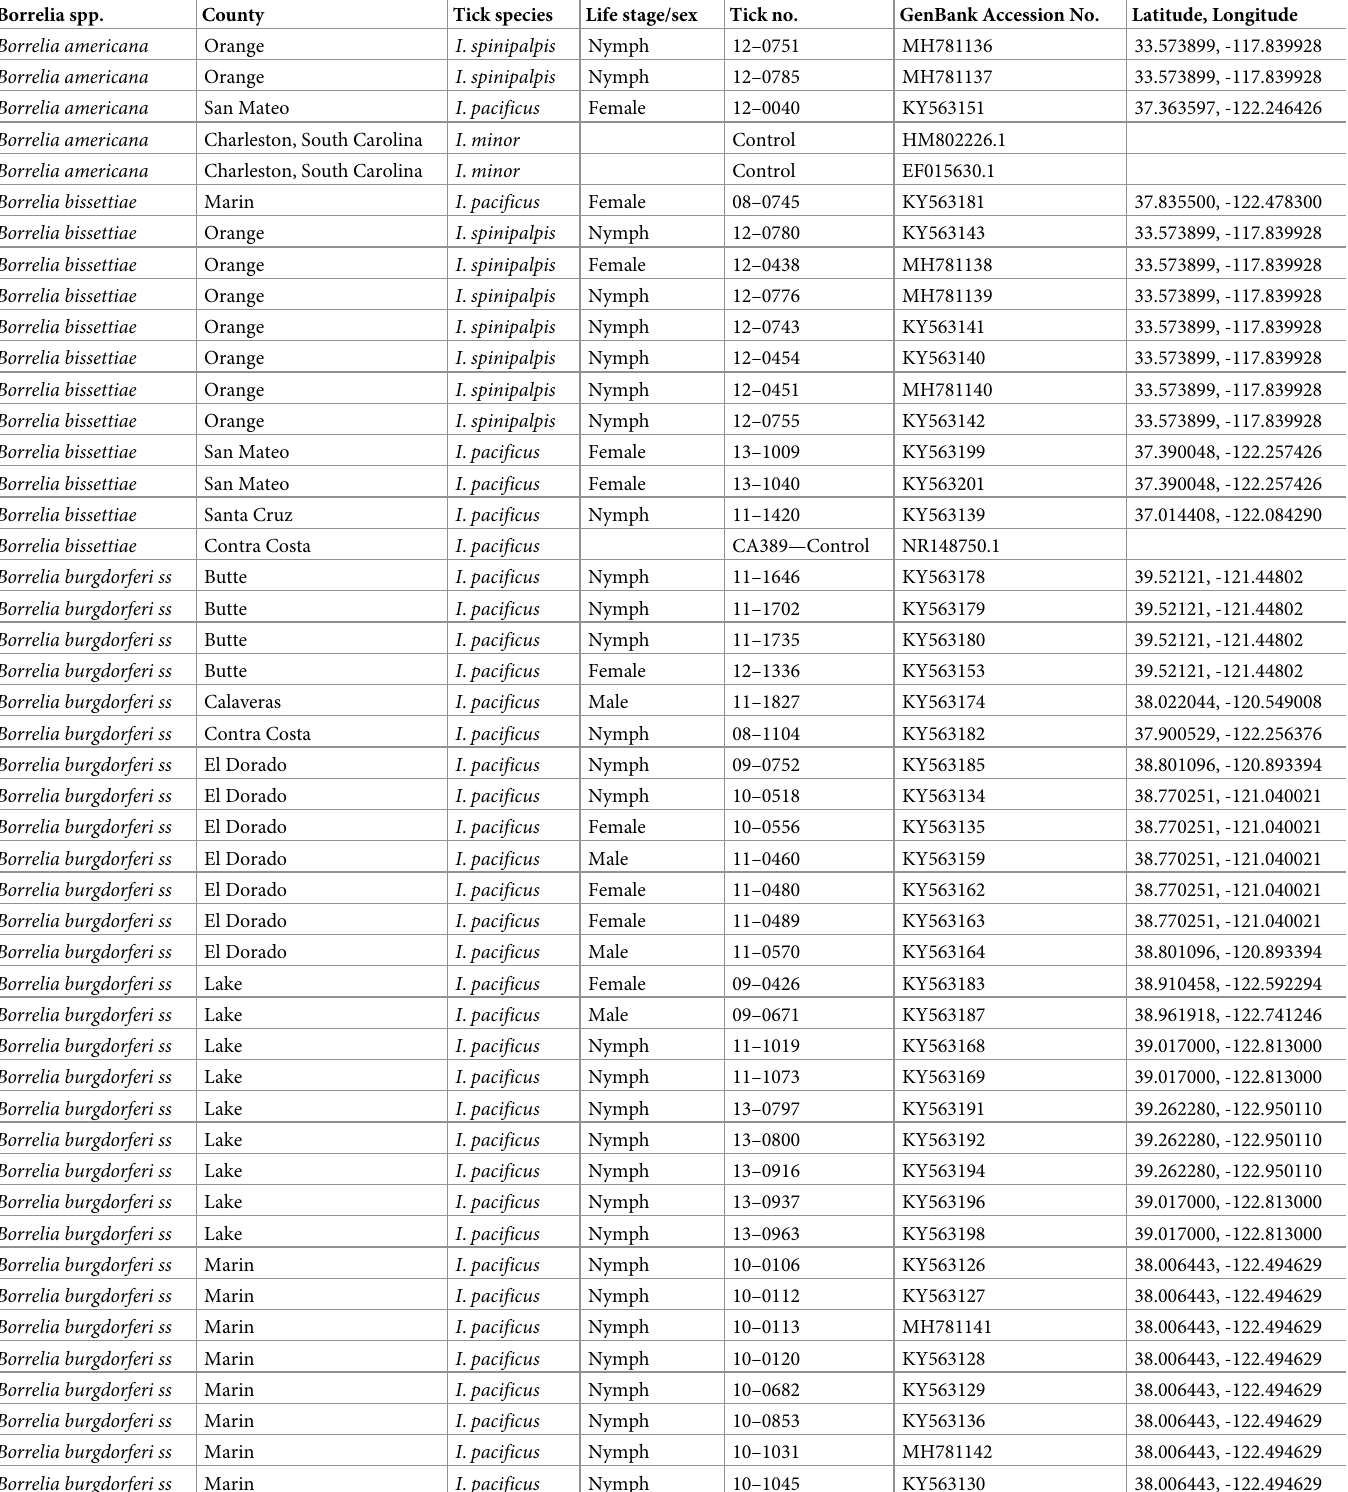
Table 2. Summary of California Borrelia positive ticks. Borrelia